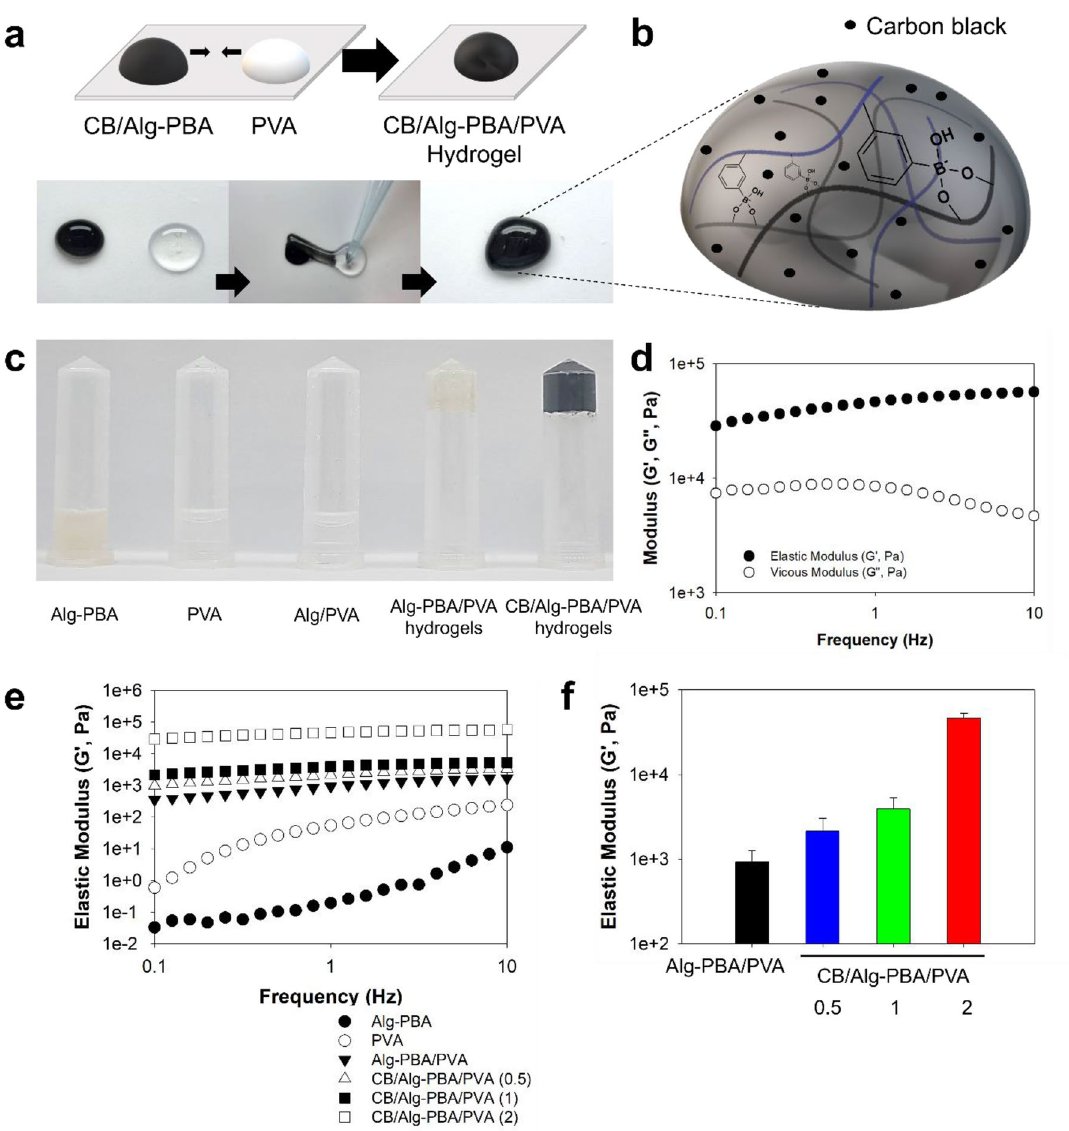
Figure 2. Preparation and characterizations of carbon black-incorporated alginate-phenylboronic acid/ polyvinyl alcohol composite hydrogels (CB/Alg-PBA/PVA hydrogels). ( a ) Schematic representative (top) and photos (bottom) of preparations of CB/Alg-PBA/PVA hydrogels. ( b ) Illustration of proposed structures of hydrogels. ( c ) Photographic images of Alg-PBA, PVA, Alg/PVA, Alg-PBA/PVA hydrogels, and CB/Alg-PBA/ PVA hydrogels. ( d ) Frequency sweep measurements of CB/Alg-PBA/PVA hydrogels. ( e ) Elastic modulus (G ′ ) changes of samples as a function of frequency. ( f ) Elastic modulus values of CB/Alg-PBA/PVA hydrogels as a function of CB